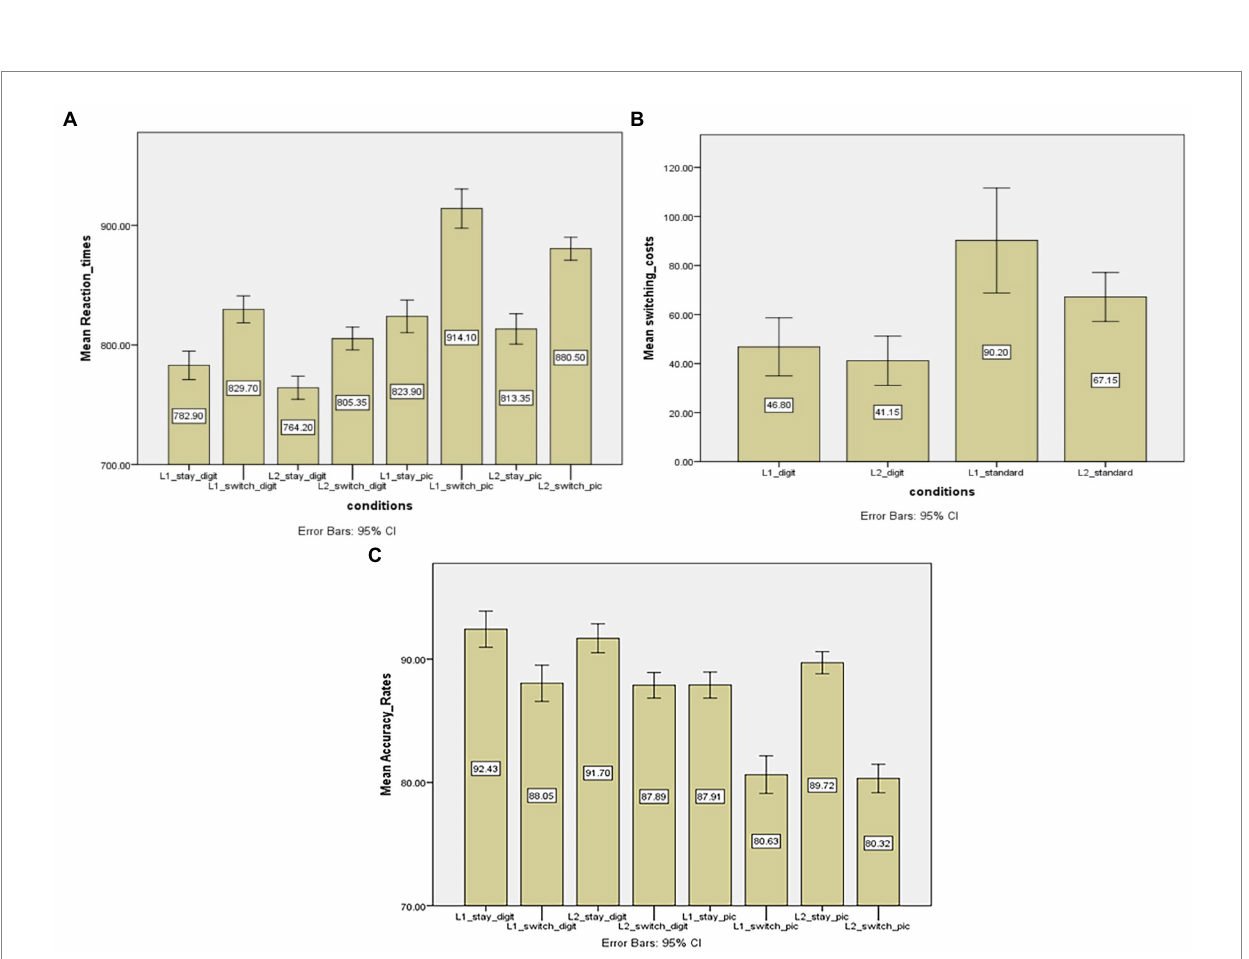
FIGURE 1 (A) Mean reaction times (in ms) of stay and switch trials across two stimulus conditions (digits vs. standard pictures). (B) Switching costs (in ms) as a function of ‘response language’ (Chinese vs. English) and ‘stimulus type’ (digits vs. standard pictures). (C) Mean accuracy rates (in percentage) of stay and switch trials across two stimulus conditions (digits vs. standard pictures). L1 = the first language, L2 = the second language. Digit = the digit block, pic = the standard picture